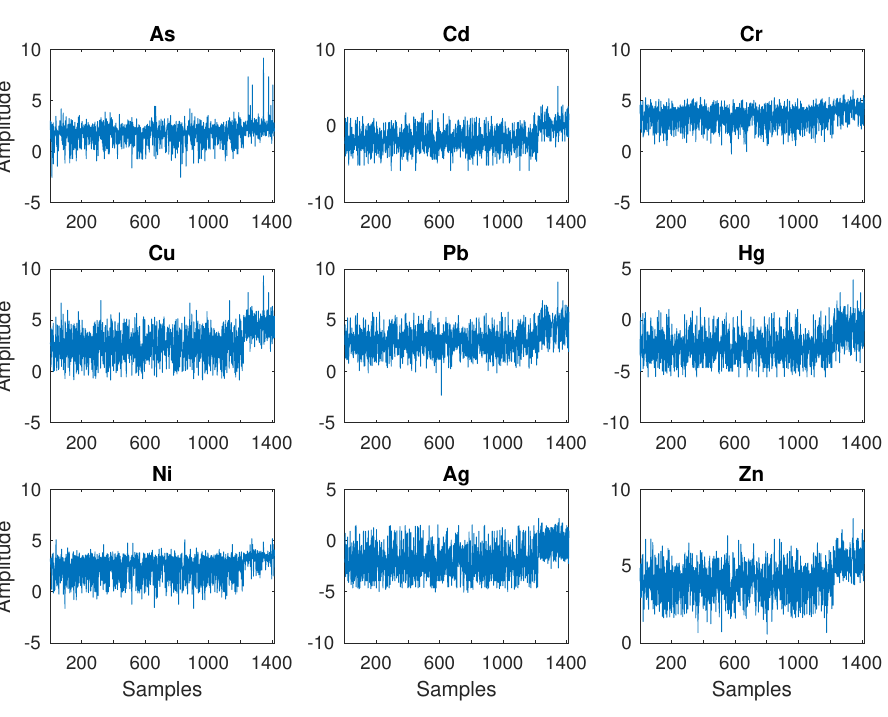
Figure 5. Sediment training data